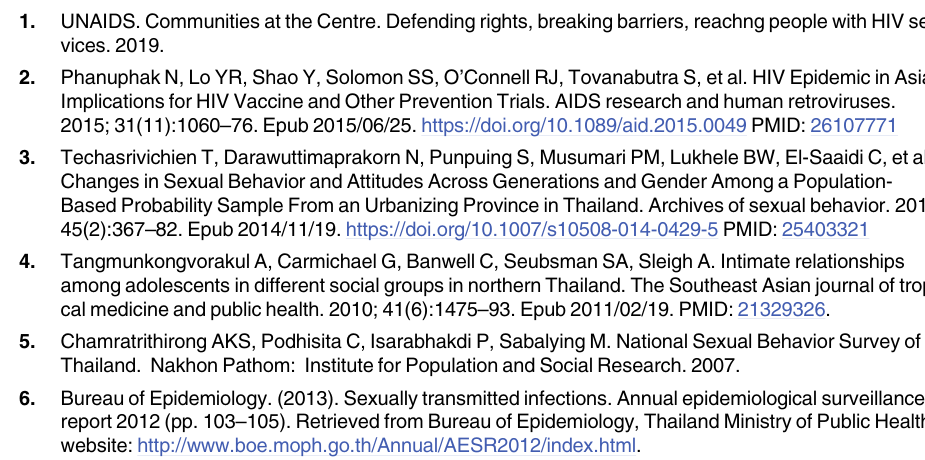
S2 Table. Sociodemographic and behavioral characteristics of the participants by intention to test for